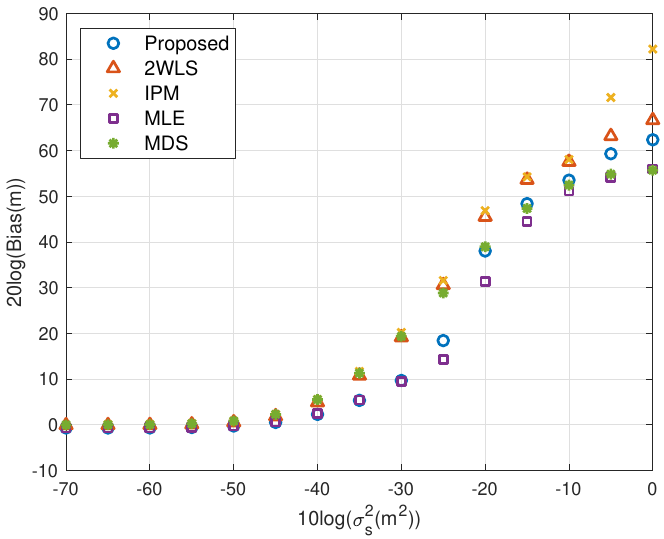
Figure 9. Bias performance as error level increasing (far source, 4